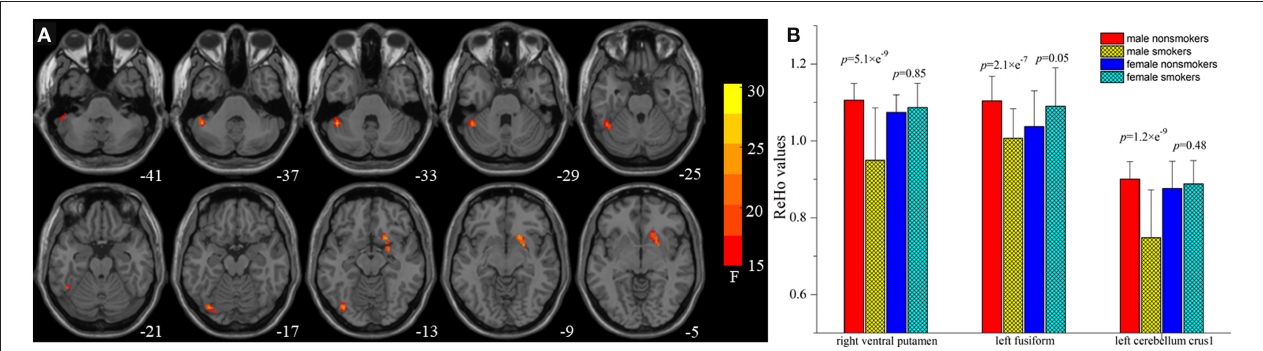
FIGURE 2 | Brain areas with interaction between smoking and sex on regional homogeneity (ReHo) by the 2-way analysis of covariance (ANCOVA) with age and education levels as covariates. (A) Brain regions showing smoking-sex interaction on ReHo include the left fusiform gyrus, left cerebellum crus1 extended to the inferior temporal gyrus, and right ventral striatum [voxel-level p < 0.05 (FDR corrected]. (B) Post-hoc 1-way ANCOVA analyses revealed that male smokers had lower ReHo than male non-smokers in the right ventral striatum ( p = 5.1 × e − 9 ), left fusiform gyrus ( p = 2.1 × e − 7 ), left cerebellum crus1 extended to the inferior temporal gyrus ( p = 1.2 × e − 9 ), whereas female smokers showed no but no differences on ReHo values in these regions.